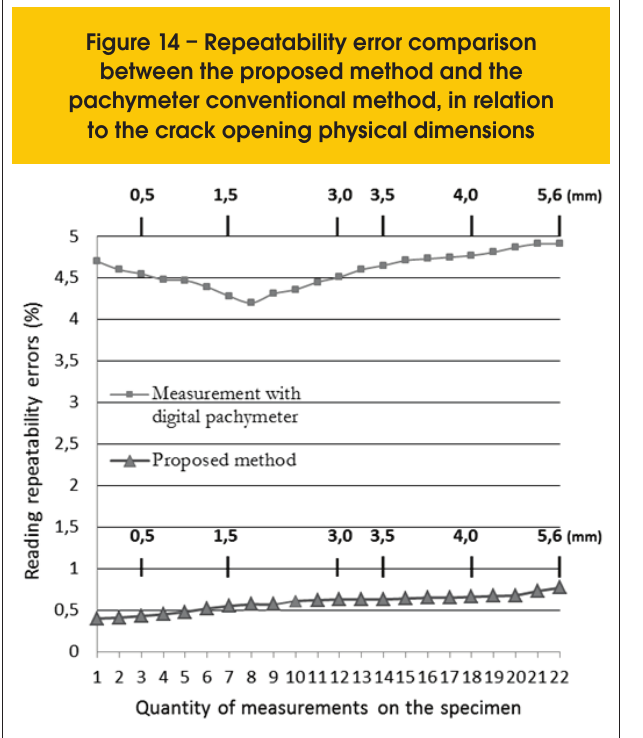
Figure 14 – Repeatability error comparison between the proposed method and the pachymeter conventional method, in relation to the crack opening physical